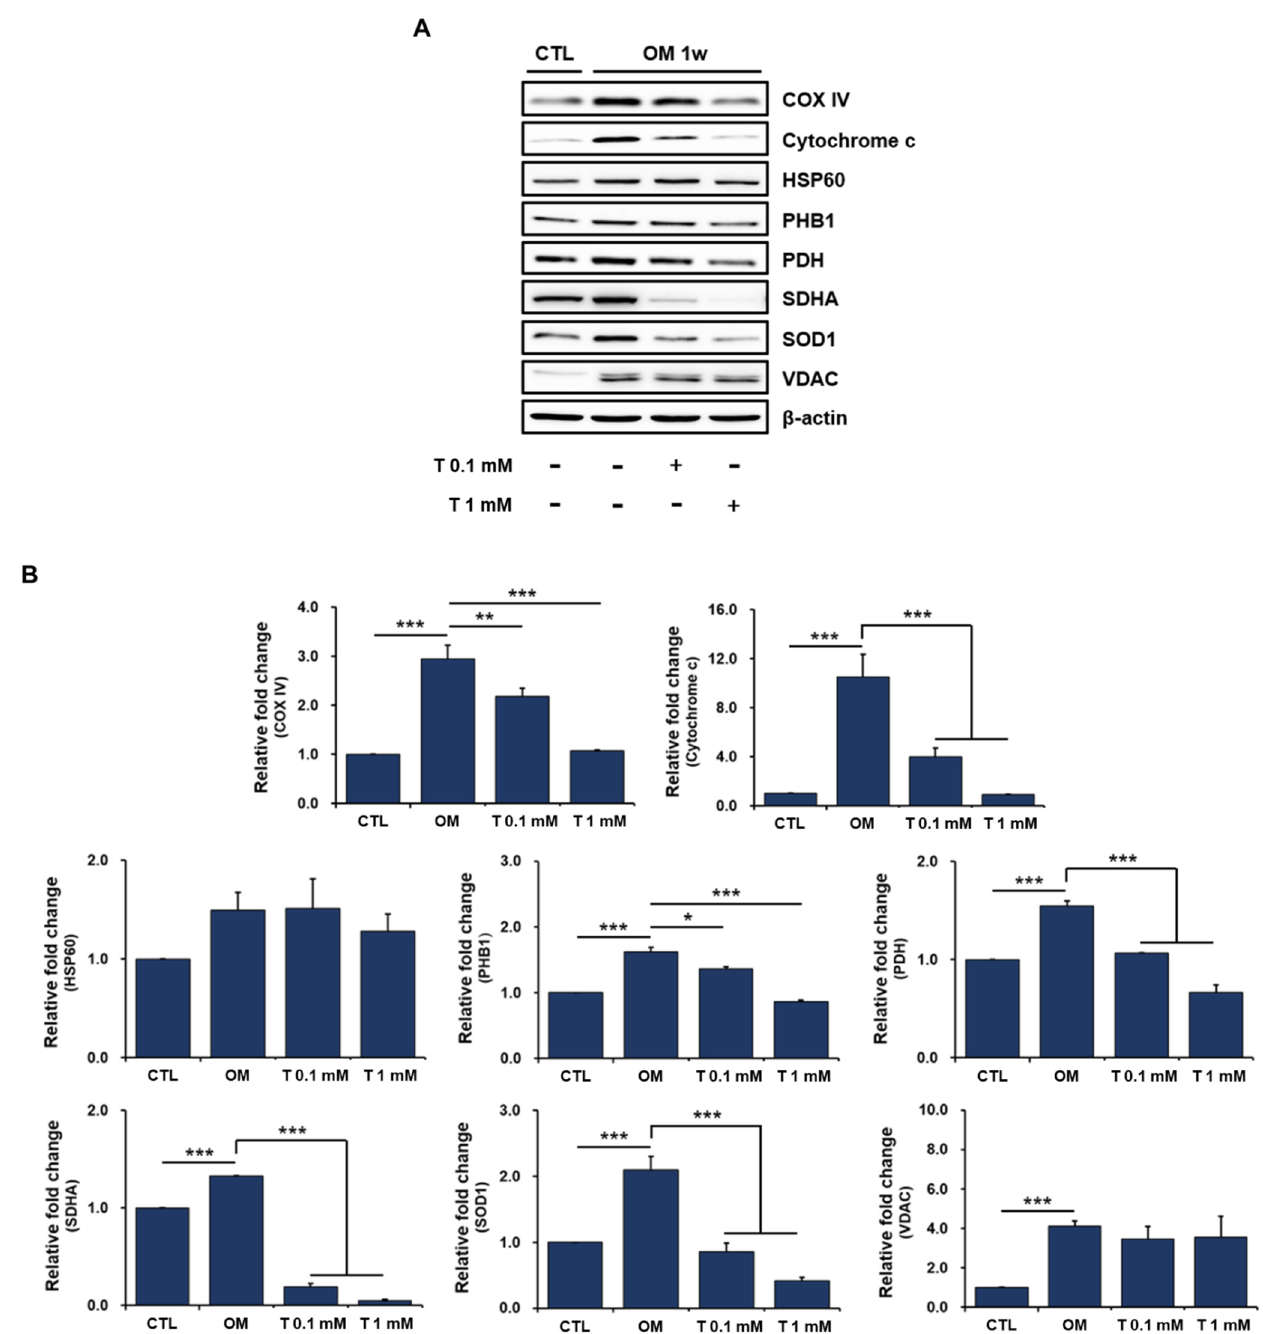
Figure 5. Effects of tiron on the level of mitochondrial proteins in osteoblast-differentiating hPDCs. ( A , B ) The levels of mitochondrial proteins were clearly increased in hPDCs cultured in osteogenic- induction medium compared with those in DMEM. Tiron markedly reversed the increases in mito- chondrial protein levels induced by osteogenic induction medium, except for HSP 60 and